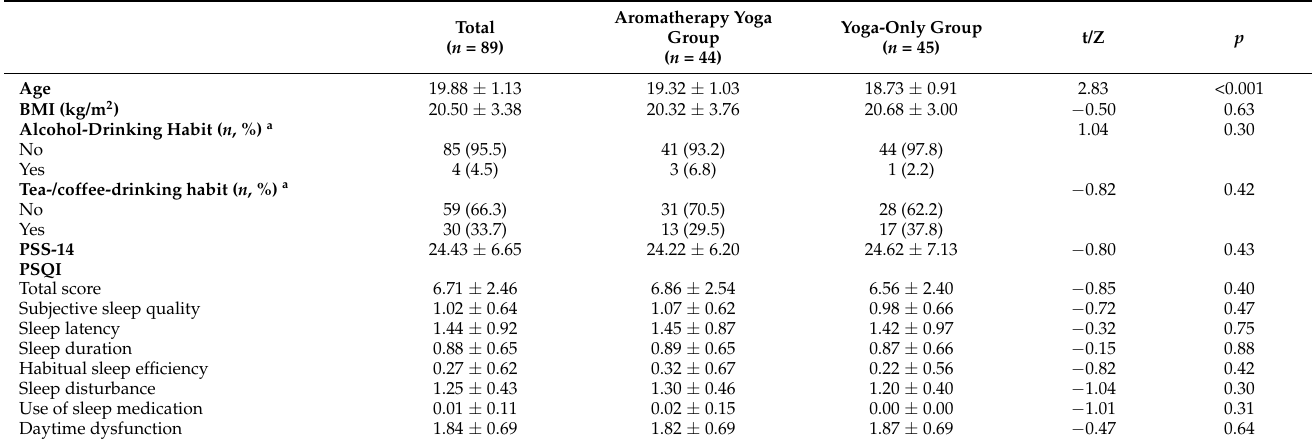
Table 1. Basic demographic information and comparison of baseline values (PSS-14 and PSQI total score with seven subscales, N =